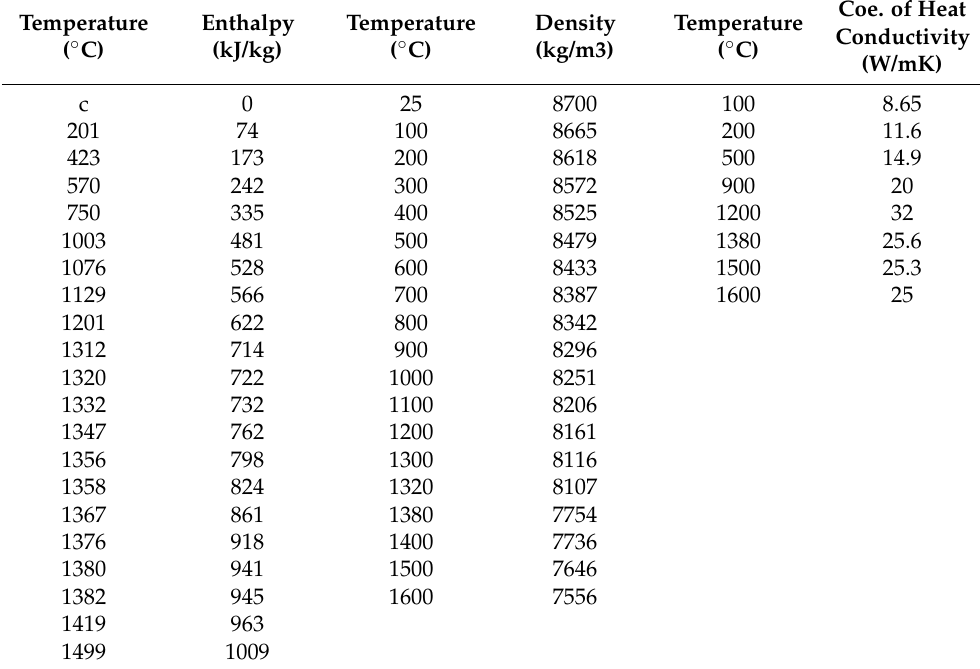
Table 3. Thermophysical parameters of CMSX-4 Superalloy.